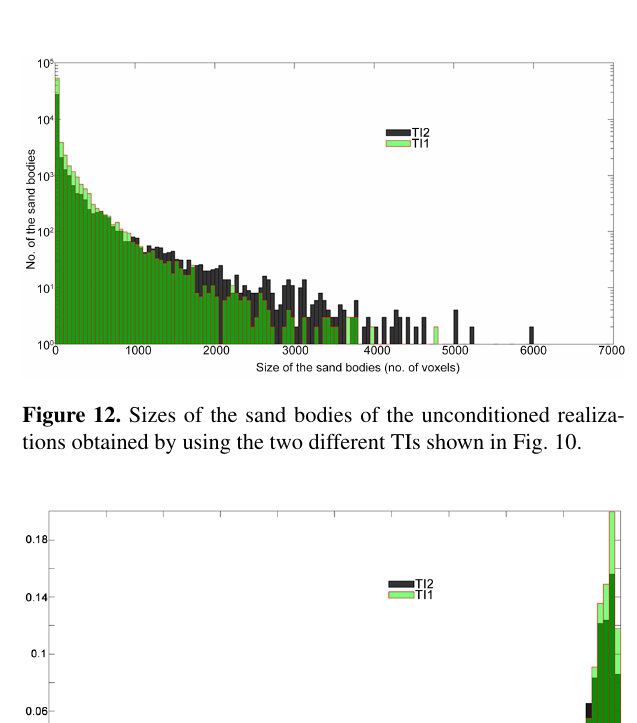
Figure 11. Profile through the unconditioned realizations obtained by using the two different TIs shown in Fig. 5. (a) Realization based on TI1 (Fig. 10a). (b) Realization based on TI2 (Fig. 10b). Vertical exaggeration = 8 × . For location of the profile, see Fig. 15.